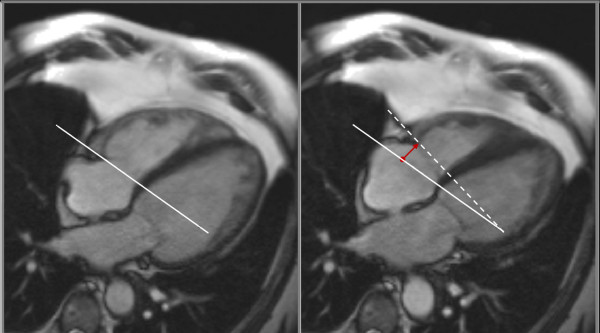
Four-chamber view in end-diastole (left panel) and end-systole (right panel). The tricuspid annular plane is marked as a white line in diastole and as a dashed line in systole. The red vector represents the tricuspid annular systolic excursion (TAPSE).